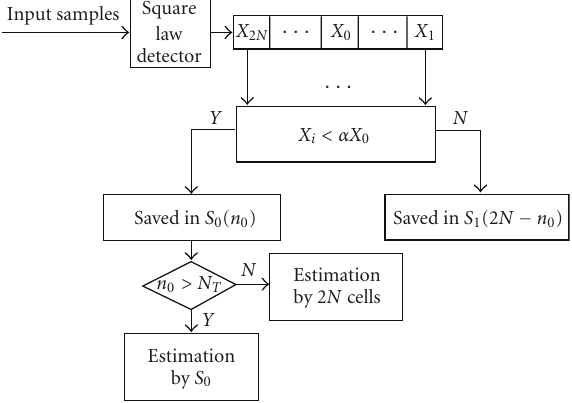
Figure 1: Block diagram of SOS CFAR